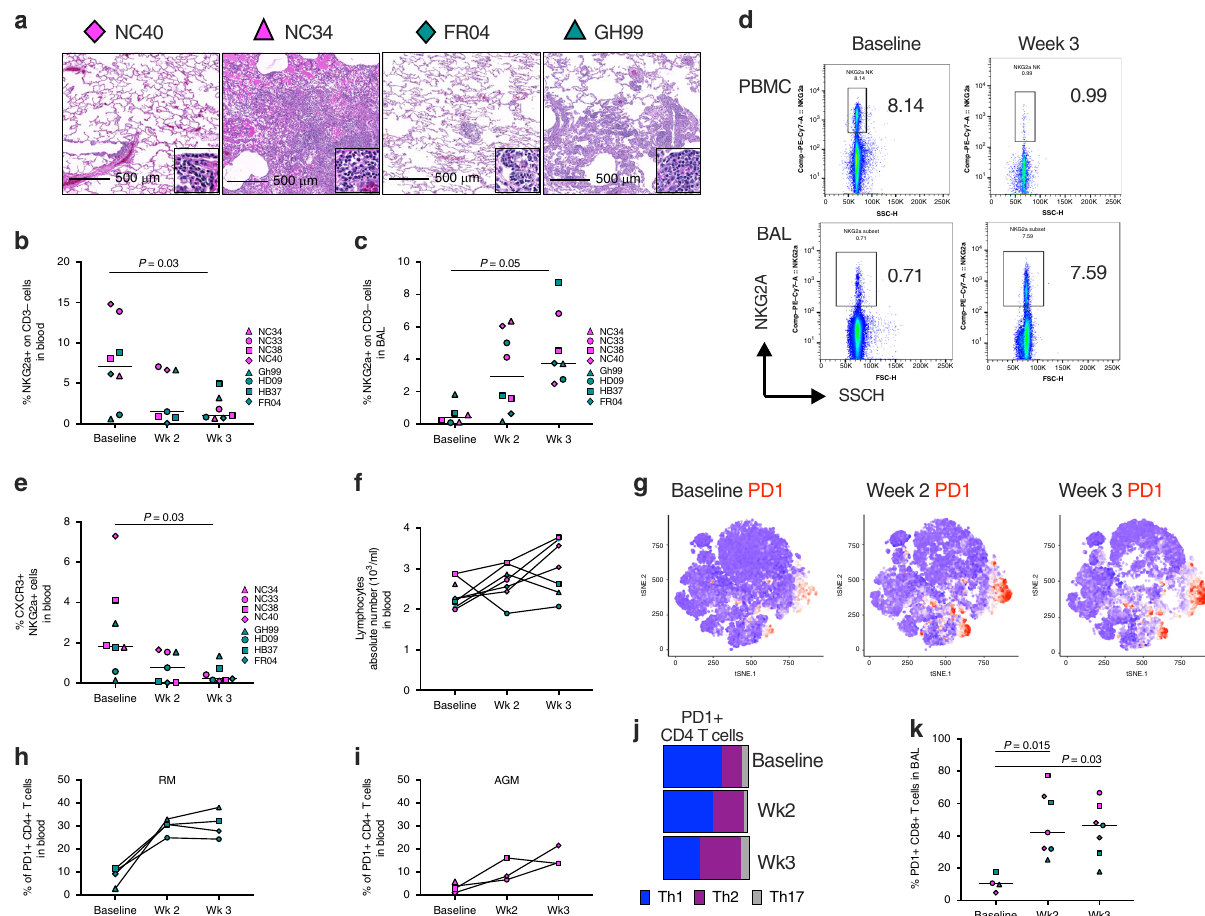
Fig. 5 Lymphocytes in fi ltration in the lungs is associated with disease severity. a Histopathologic fi ndings showing in fi ltration of lymphocytes in the lung of AGM (NC40 and NC34) and RM (FR04 and GH99) with mild (NC40 and FR04), moderate (GH99), and severe disease (NC34). b Frequency of NKG2a + cells in the blood or c BAL of 4 AGM and 4 RM at baseline, 2 weeks and 3 weeks post SARS-CoV-2 infection by fl ow cytometry. d Representative fl ow cytometry plot showing a decreased frequency of NGK2a + cells in PBMCs and increased frequency in BAL to baseline in at week 3 post-SARS-CoV-2 infection respect to baseline. One animal for each species is shown. e Decrease in the frequency of CXCR3 + NKG2a + cells in the blood at 2 weeks and 3 weeks post SARS-CoV-2 infection compared to the baseline. f Absolute number of lymphocytes before and after infection. g tSNE plots displaying kinetics of PD-1 expression (in red) on lymphocytic cell populations over time. h Frequency of PD-1 + Th2 (CXCR3 − CCR6 − ) CD4 + T cells is increased in RM and i in AGM overtime following the infection. j Changes in the percentage of Th2 (purple), Th1 (blue) and Th17 (gray) cells within the total PD-1 + CD4 + T cell population. k Signi fi cant increase in the percentage of PD-1 + CD8 + T cells in BAL. Analysis of variance (ANOVA) was used for comparing statistical differences between multiple groups, followed by Dunn ’ s multiple comparison tests for b , c , and k